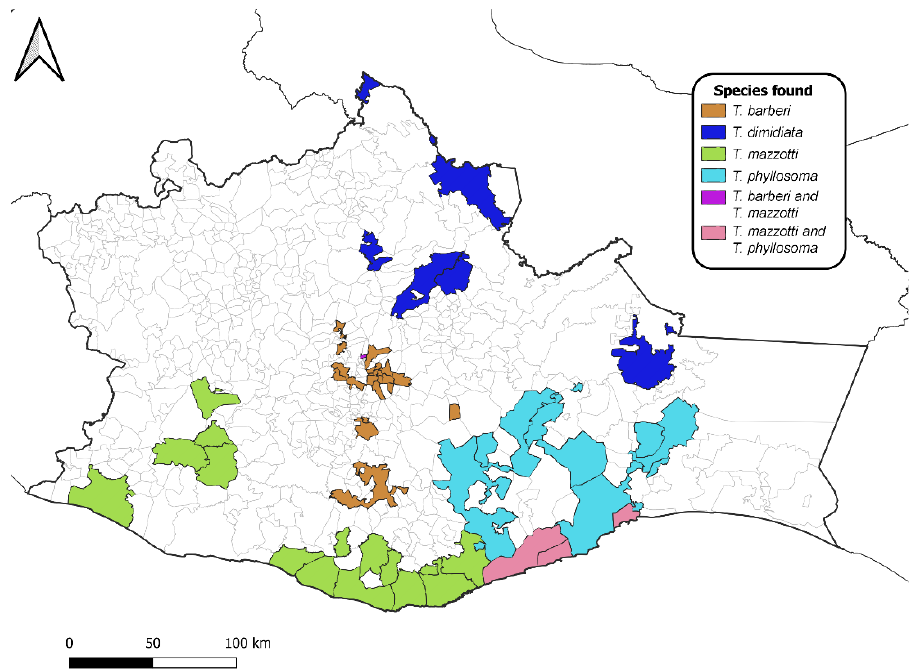
Figure 2. Actual distribution of the four predominant domestic species of Triatominae in the state of Oaxaca, México: Triatoma barberi , T. dimidiata , T. mazzotti , and T. phyllosoma (including T. phyllosoma picturata ).